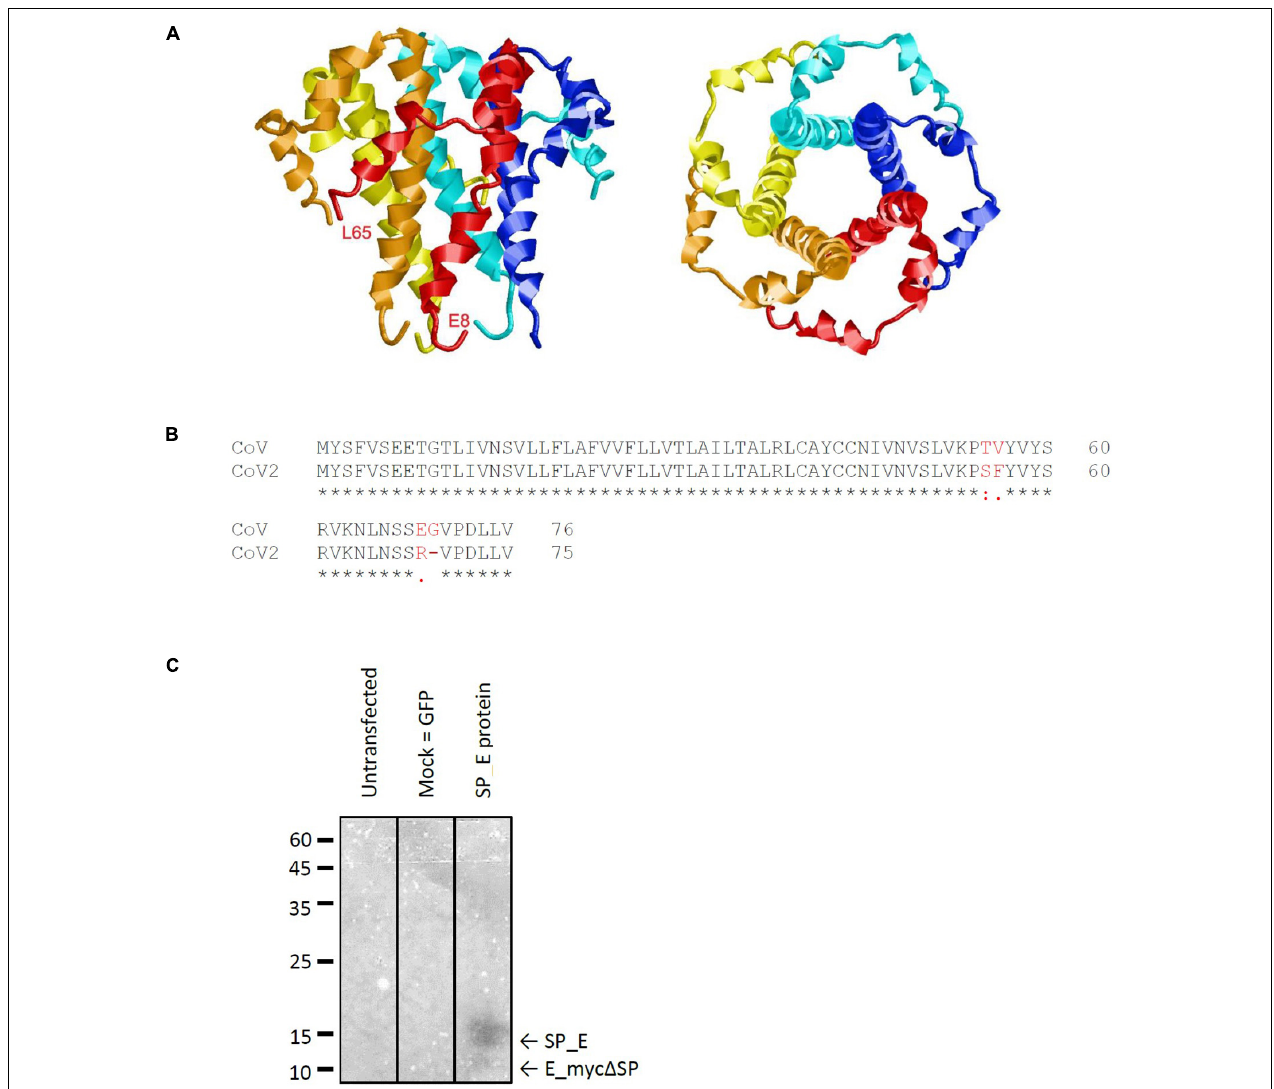
FIGURE 1 | Characteristics of the SARS CoV E protein. (A) Structural model of the E protein (PDB code: 5X29) determined by NMR Spectroscopy in lyso-myristoyl phosphatidyl-glycerol (LMPG) micelles (Surya et al., 2018). The five subunits are shown in different colors and the N- and C-terminal residues resolved in the structure are labeled for one subunit. (B) Sequence alignment of the E protein of SARS against that of SARS CoV-2 reveals four amino acid exchanges. (C) Western blot analysis of recombinantly expressed SARS CoV E protein including a membrane directed signal peptide (SP_E). The theoretical sizes of E protein with and without signal sequence are 16.37 kDa (SP_E) and 12.4 kDa (E_myc (cid:49) SP),